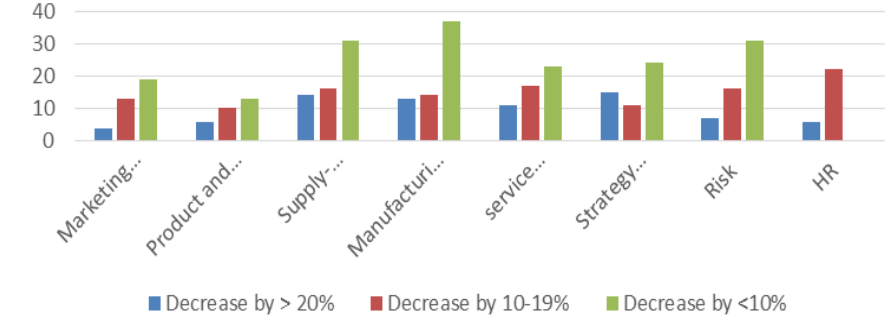
Figure 2. Average cost reduction [9